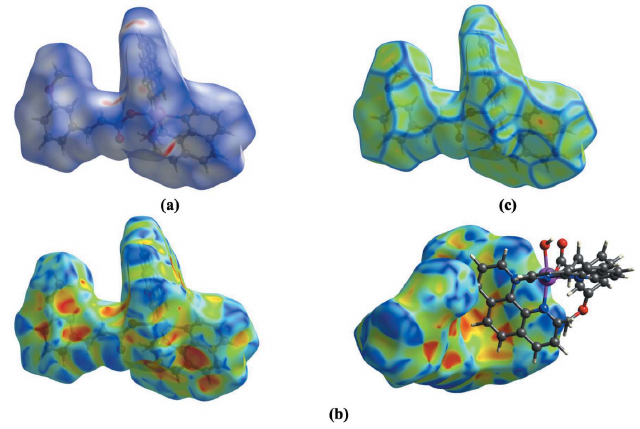
Figure 4 A view of the Hirshfeld surface mapped over ( a ) d norm in the range (cid:5) 0.5087 to +1.3878 arbitrary units, ( b ) shape-index and ( c ) curvedness.